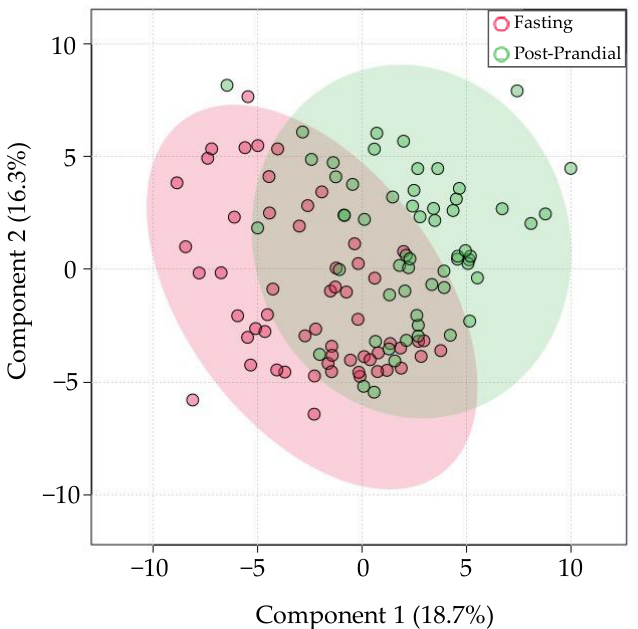
Figure 4. Differences in prandial status are responsible for a moderate amount of saliva miRNA variation. PLS-DA scores plot between groups fasting (red) and post-prandial (green) samples.